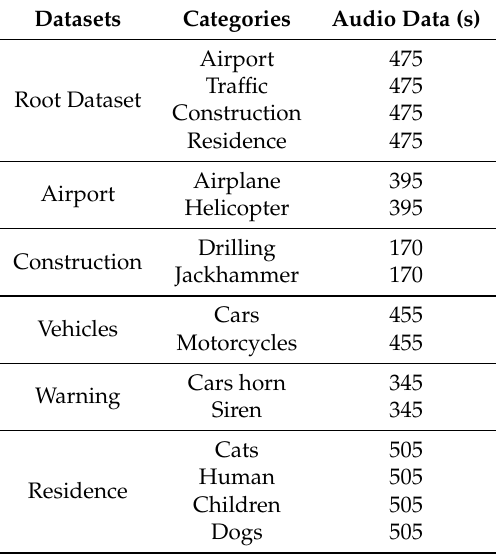
Table 6. Summary of the categories used in the hierarchical dataset.